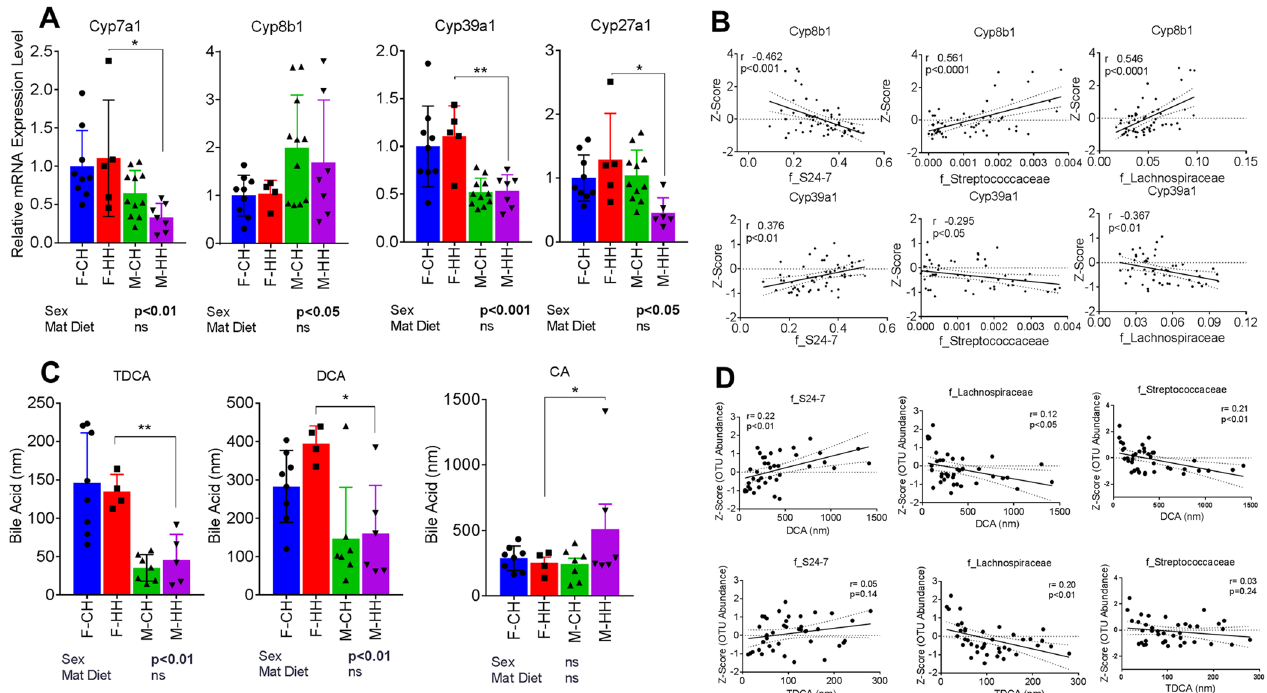
Figure 8. Sexual dimorphism in BA metabolites and regulatory enzymes and associations with microbial families. ( A ) mRNA expression of bile acid synthesis related genes Cyp7a1, Cyp8b1, Cyp39a1 and Cyp27a1 in livers of offspring. ( B ) Associations between Cyp8b1 and Cyp39a1 mRNA levels and bacterial families. ( C ) Serum concentrations of bile acids TDCA, DCA and CA in offspring. ( D ) Associations between DCA and TDCA concentrations and bacterial families. Data are expressed as means ± SD. Statistical differences in gene expression were determined using a two-way ANOVA to examine the effects of maternal HF and offspring sex, followed by Student-Newman-Keuls post hoc analyses. ( * p < 0.05, ** p < 0.01 *** p <